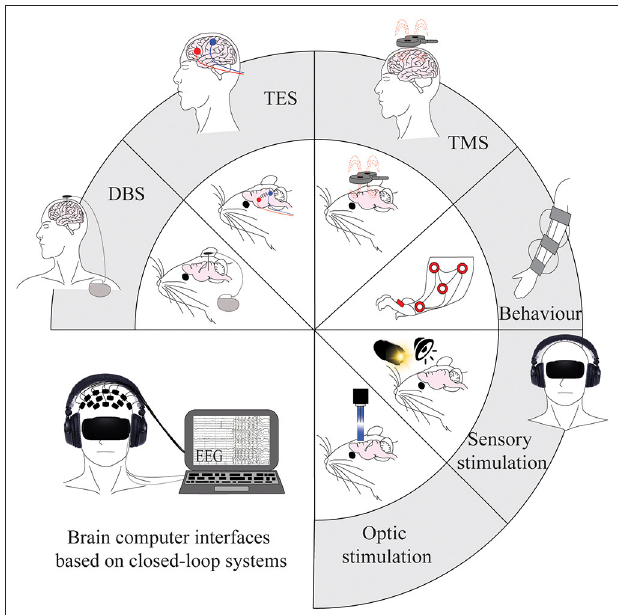
FIGURE 2 | Tools for modulating brain activity post-stroke in human and animal models. Current invasive and non-invasive brain stimulation, sensory stimulation, and optogenetic tools that are used to modulate brain oscillations. Applications are shown on animal models in the inner circle, with the corresponding applications on human patients in the outer part of the circle. The figure in the bottom left represents a combination of current methods and integrates them into a non-invasive closed-loop design that could be considered for future research. DBS, deep brain stimulation; TES, transcranial electric stimulation; TMS, transcranial magnetic